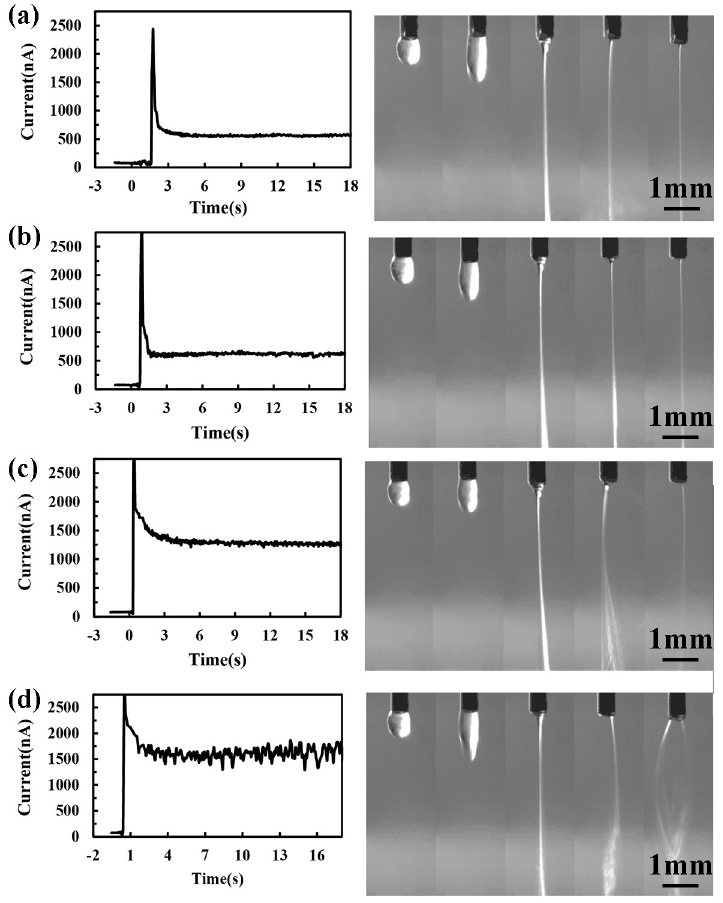
Figure 4. Relationship between electrohydrodynamic direct-written current and ejection time under different applied voltages: ( a ) 3.3 kV; ( b ) 3.6 kV; ( c ) 3.9 kV; and, ( d ) 4.2 kV. The distance between spinneret and collector, the solution concentration and the solution supply rate were 6 mm, 10%, and 100 µ L/h,